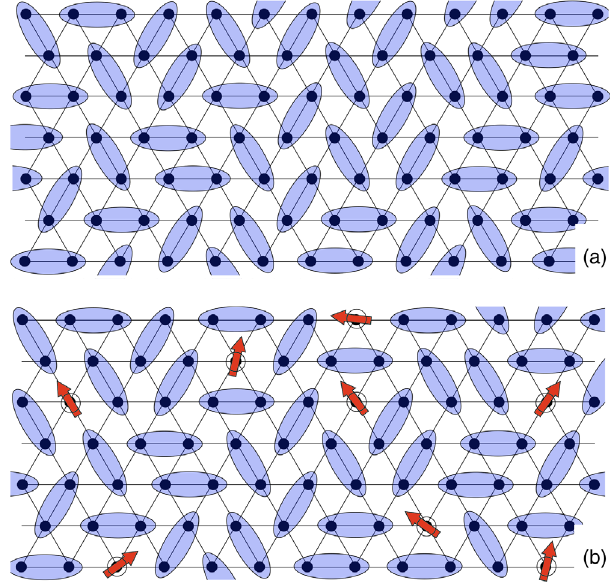
FIG. 2. Pinned singlets instability. (a) The putative 2D valence- bond glass phase consists of pinned short-ranged singlets. (b) We find that in the thermodynamic limit such a valence-bond glass is unstable to the nucleation of defect monomers that carry spin 1 = 2 . The RG flow from the resulting random spin network then determines the low-energy physics, as in Fig.